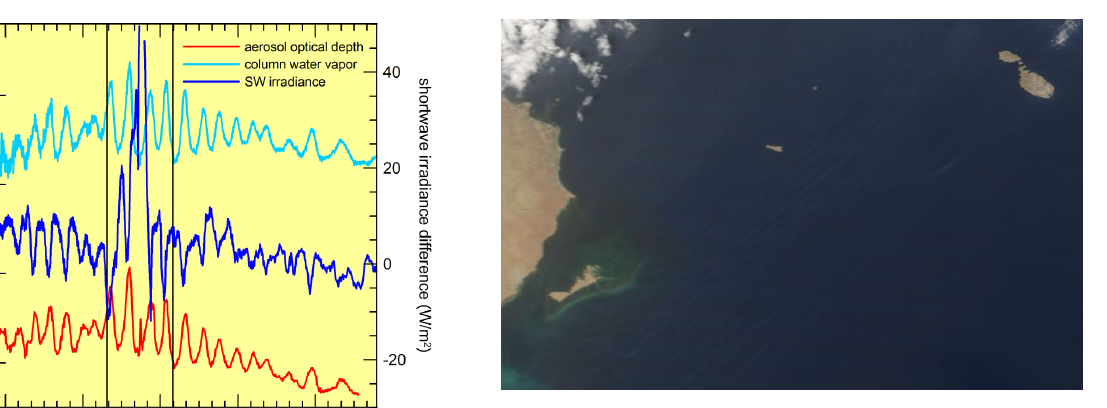
Fig. 3. True colour image of the central Mediterranean from the Fig. 3. True-colour image of the central Mediterranean from the MODIS instrument on 610 board the Terra satellite for 7 September, 2005, at 9:25 UT. Lampedusa is in the centre 611 MODIS instrument on board the Terra satellite for 7 September of the image; the Tunisian coast is on the left, and Malta in the upper right corner. The 612 2005, at 09:25UTC. Lampedusa is in the centre of the image; the modulation of the aerosol produced by the wave propagation is evident South East of 613 Tunisian coast is on the left, and Malta in the upper right corner. Lampedusa. 614 The modulation of the aerosol produced by the wave propagation is 615 evident southeast of